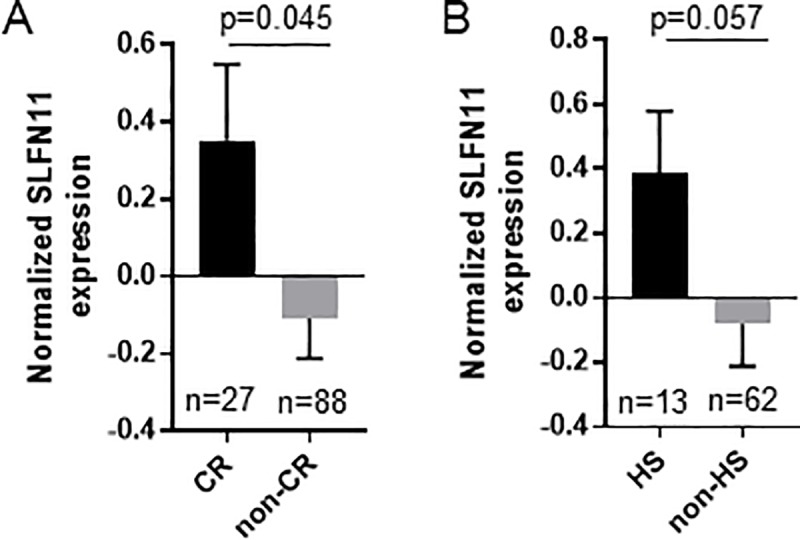
Patients with tumors highly responsive to chemotherapy have high SLFN11 transcript levels.Z-score normalized RNA expression and tumor response data were obtained for primary breast and ovarian tumors from 2 datasets containing information from 115 breast cancer patients (A) and 75 ovarian cancer patients (B) treated with neoadjuvant chemotherapy. Breast cancer patients were divided into patients who had a pathologic Complete Response after chemotherapy (pCR), to those that did not (non-pCR), and SLFN11 expression was compared by Student t-test with Welch’s correction. Ovarian cancer patients were divided into patients who were highly sensitive (HS; defined as DFS>732 days according to [15]) or not (non-HS), and analyzed as above.